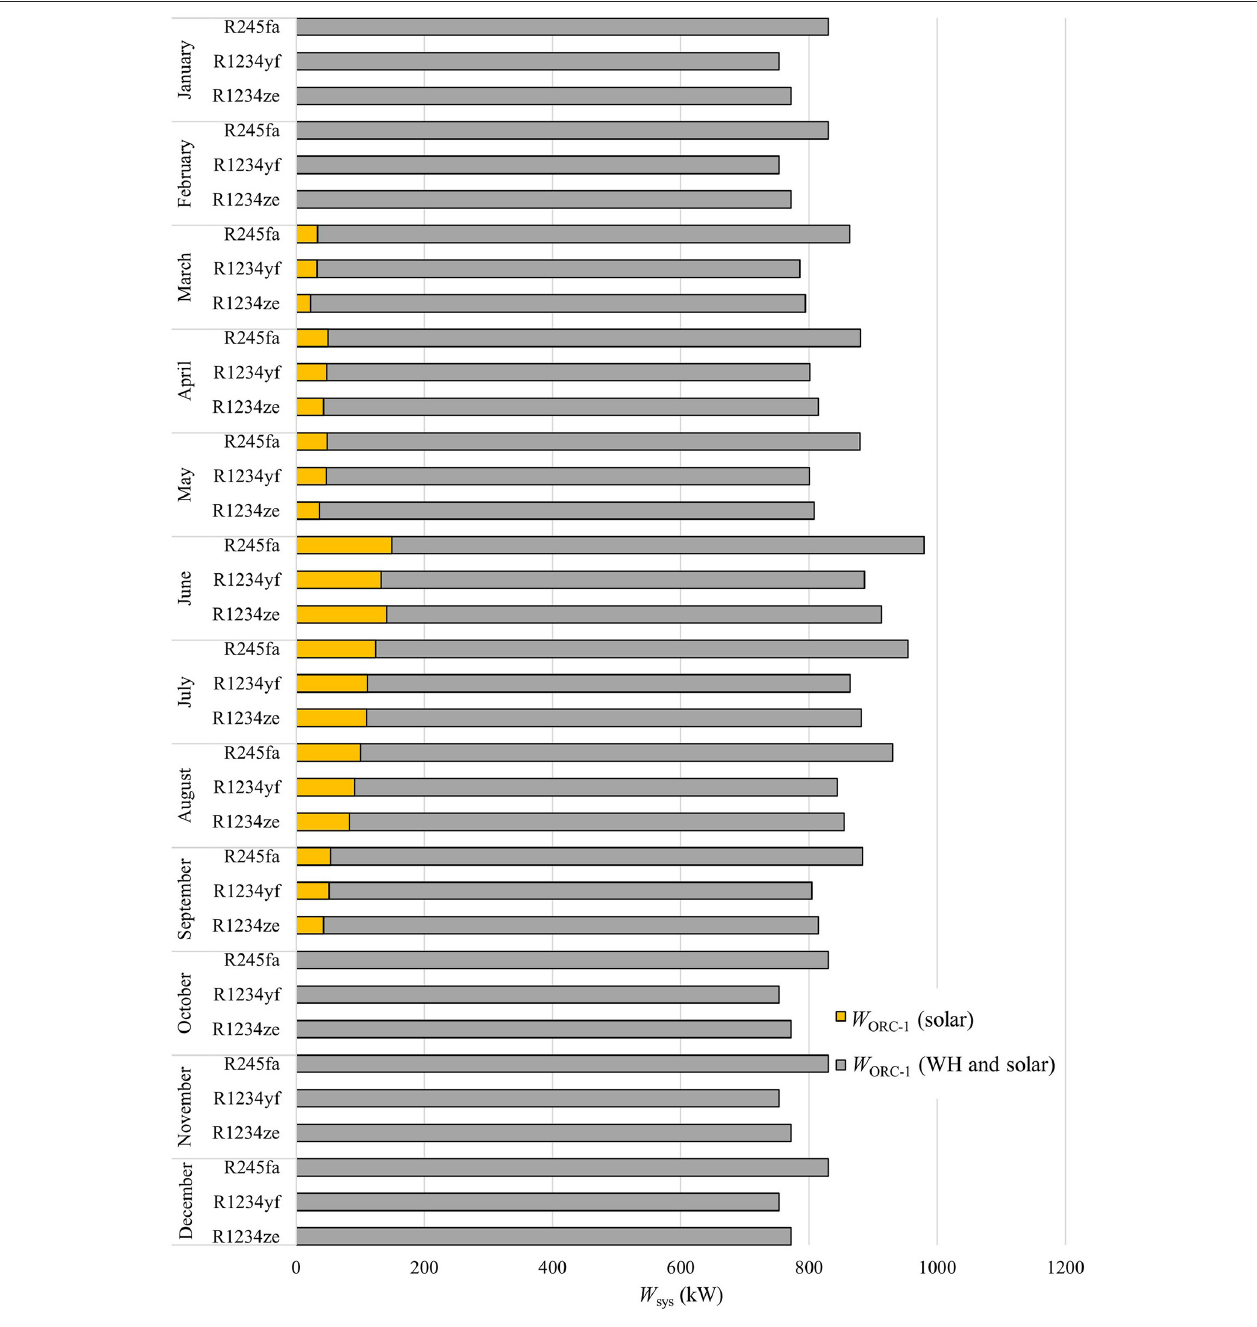
FIGURE 10 | Power output of ORC-1 obtained from waste heat and solar in monthly